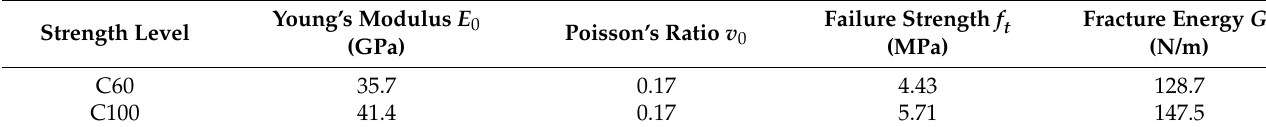
Figure 3. Geometry of the notched concrete beam under three-point bending. Table 1. Material parameters for notched concrete beams.